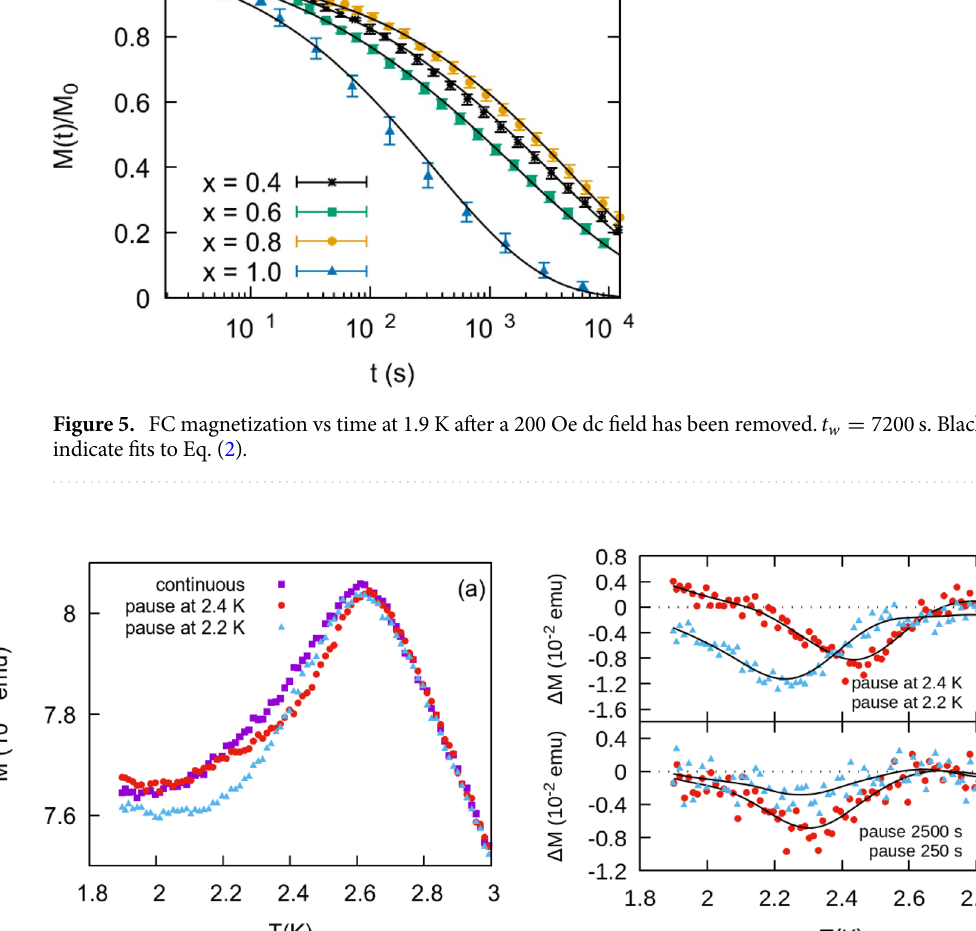
0.8 at H 50 Oe. On separate measurements the system is paused at 2.2 and Figure 6. (a) ZFC curves for x = = 2.4 K. (b) (cid:31) M for the curves in (a) . (c) (cid:31) M for ZFC curves paused at 250 and 2500 s at 2.3 K. Black lines are included as a guide for the